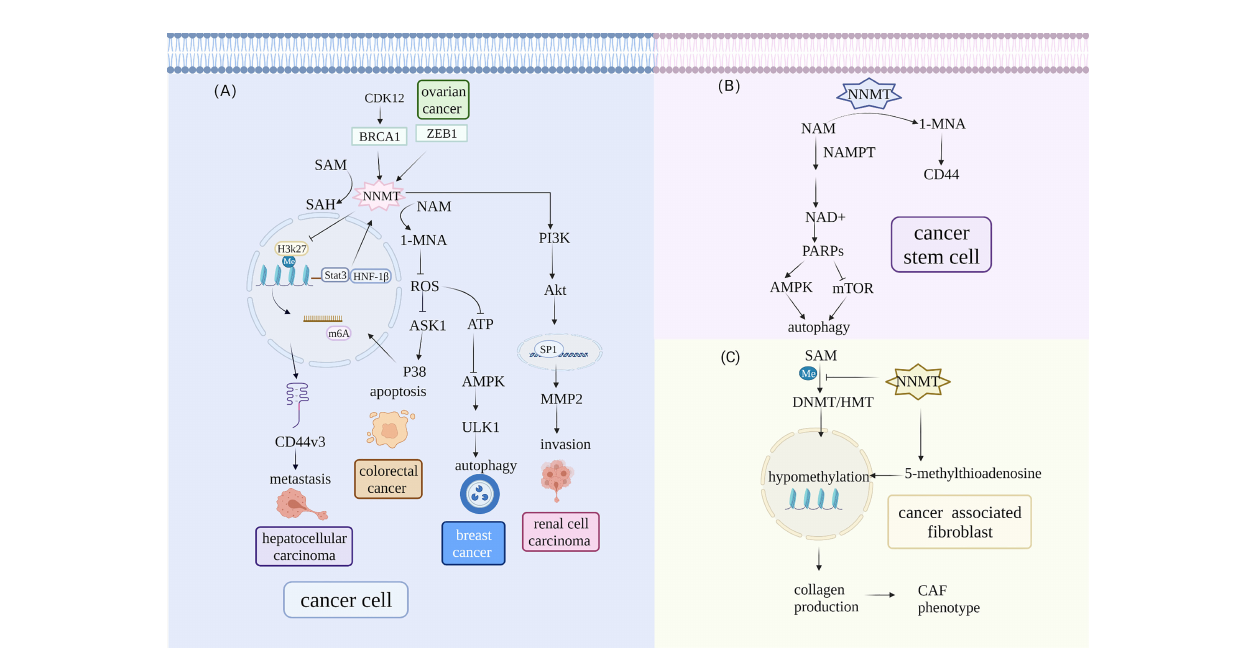
FIGURE 1 | NNMT participates in different signaling pathways in the TME. (A) NNMT expression is directly regulated by transcription factors and subsequently affects metastasis, invasion, apoptosis, and autophagy via a series of downstream signal pathways in cancer cells. Hepatocyte nuclear factor 1 b (HNF-1 b ) and STAT3 can regulate NNMT levels. Moreover, BRCA1 can occupy the NNMT promoter and regulate NNMT expression. In hepatic stellate cells, upregulated NNMT expression alters H3K27 methylation status and affects the N6-methyladenosine (m6A) of CD44, which contributes to tumor metastasis. NNMT promotes clear cell renal cell carcinoma invasion and metastasis by altering matrix metalloproteinase 2 expression. NNMT also lowers the phosphorylation of AKS1 that is an upstream signal of the p38-MAPK pathway and reduces apoptosis in colorectal cancer cells. NNMT can alter protein phosphatase2A methylation status and in fl uence ULK1 activity to regulate autophagy in breast cancer. (B) NNMT regulates autophagy in CSCs by in fl uencing NAD + metabolism. NNMT decreases the activity of NAD +-dependent enzyme PARP1 that can in fl uence autophagy by upregulation AMPK pathway and downregulation mTOR pathway in CSCs. (C) NNMT overexpression contributes to global hypomethylation and promotes CAF formation. NNMT can elevate 5-methylthioadenosine levels and contribute to global hypomethylation, which alters the methylation status of genes involved in collagen production and promotes Normal fi broblasts acquiring CAF